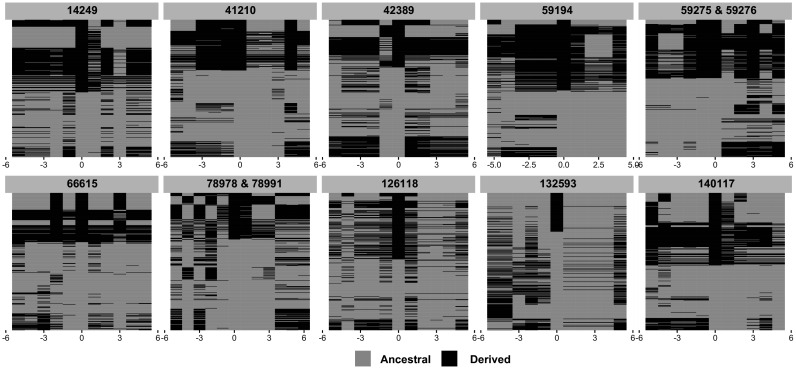
Associations of significantly associated SNPs and their neighboring SNPs, to attempt to determine if gene conversion is the cause of the recurrent evolution of the viral haplotype.The significantly associated SNPs are shown at position 0, with the 5 SNPs upstream (−5 to −1) and downstream (1 to 5) plotted around them for each strain. Derived allele strains are shown in black, while ancestral allele strains for each position are shown in gray. For the helicase-2 allele (132593), windows are plotted as derived if the allele frequency is greater than 0.5.